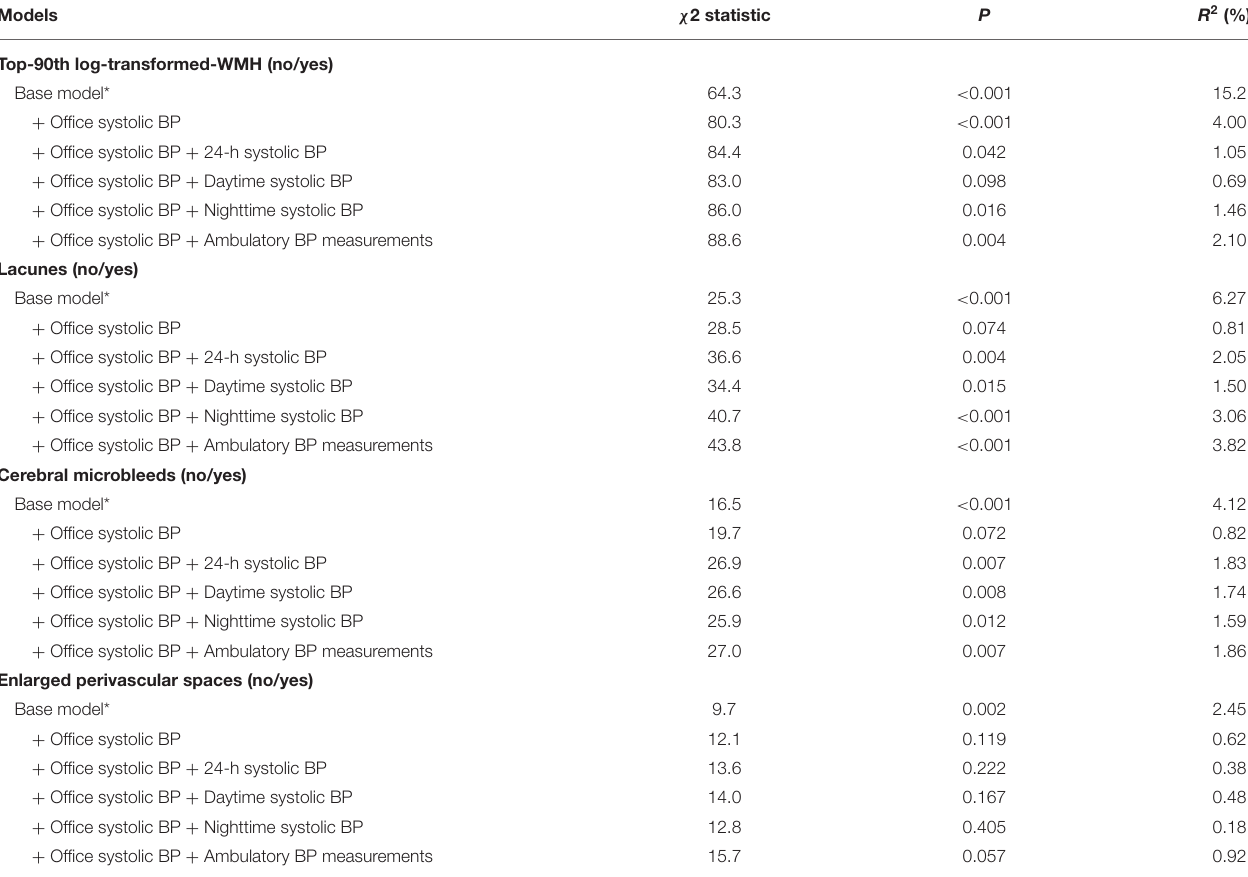
TABLE 4 | Nested fit of logistic models relating quantitative and categorical subclinical markers of cerebral small vessel disease and blood pressure measurements.